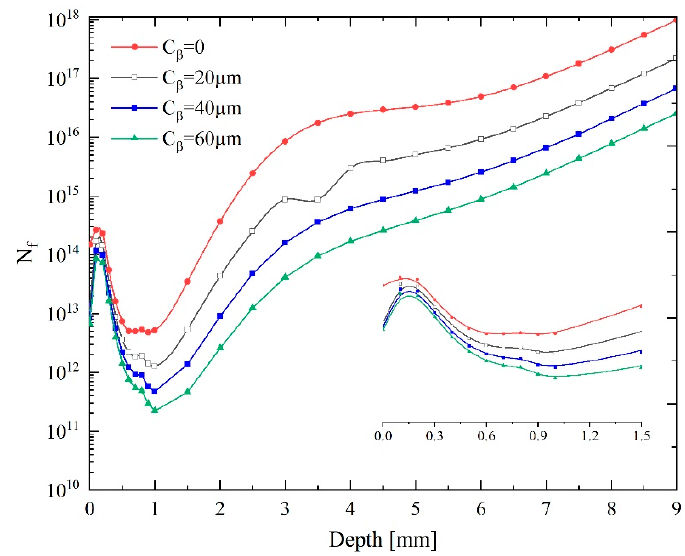
Figure 20. Influence of crowning modification on fatigue life.